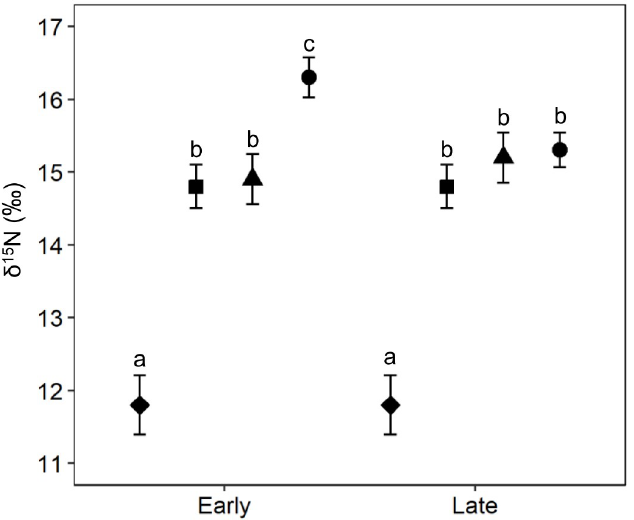
Fig 4. Least squares means and standard error of δ 15 N values of primary feathers of Black-faced Spoonbill chicks according to chick-rearing period and breeding colony. Means with the same letter are not significantly different (Tukey’s post hoc